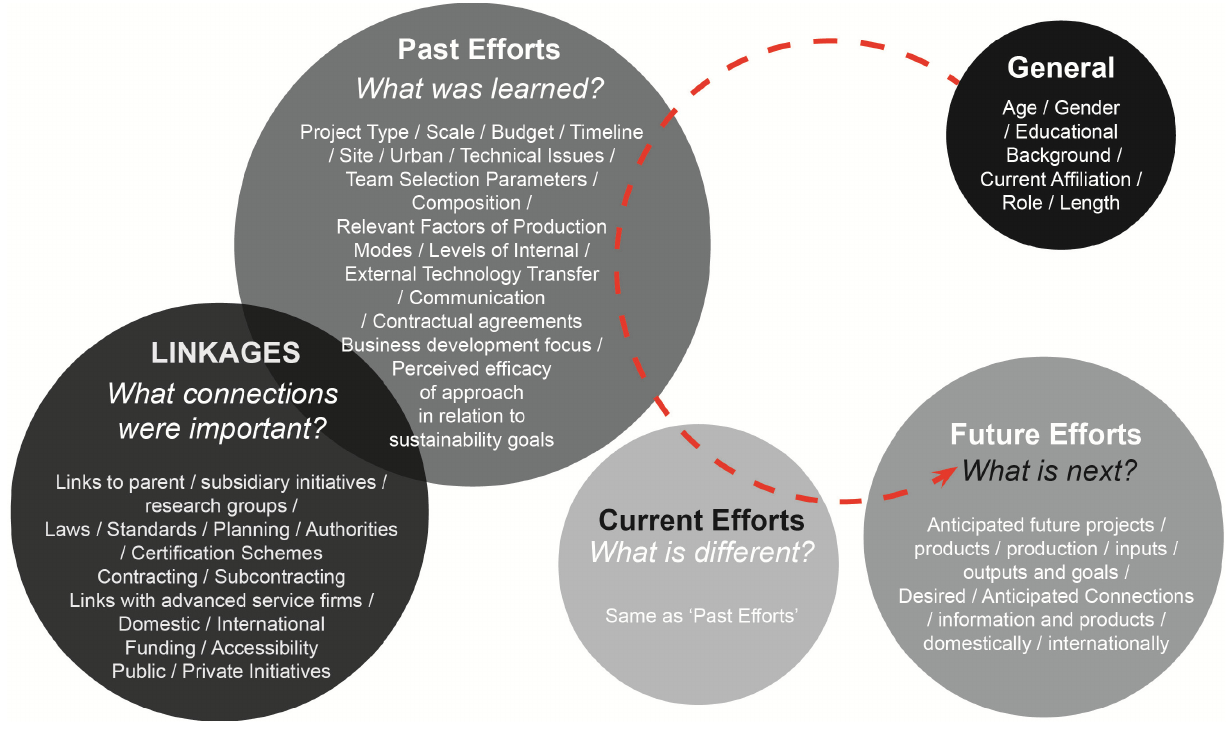
Figure 6. Discussion